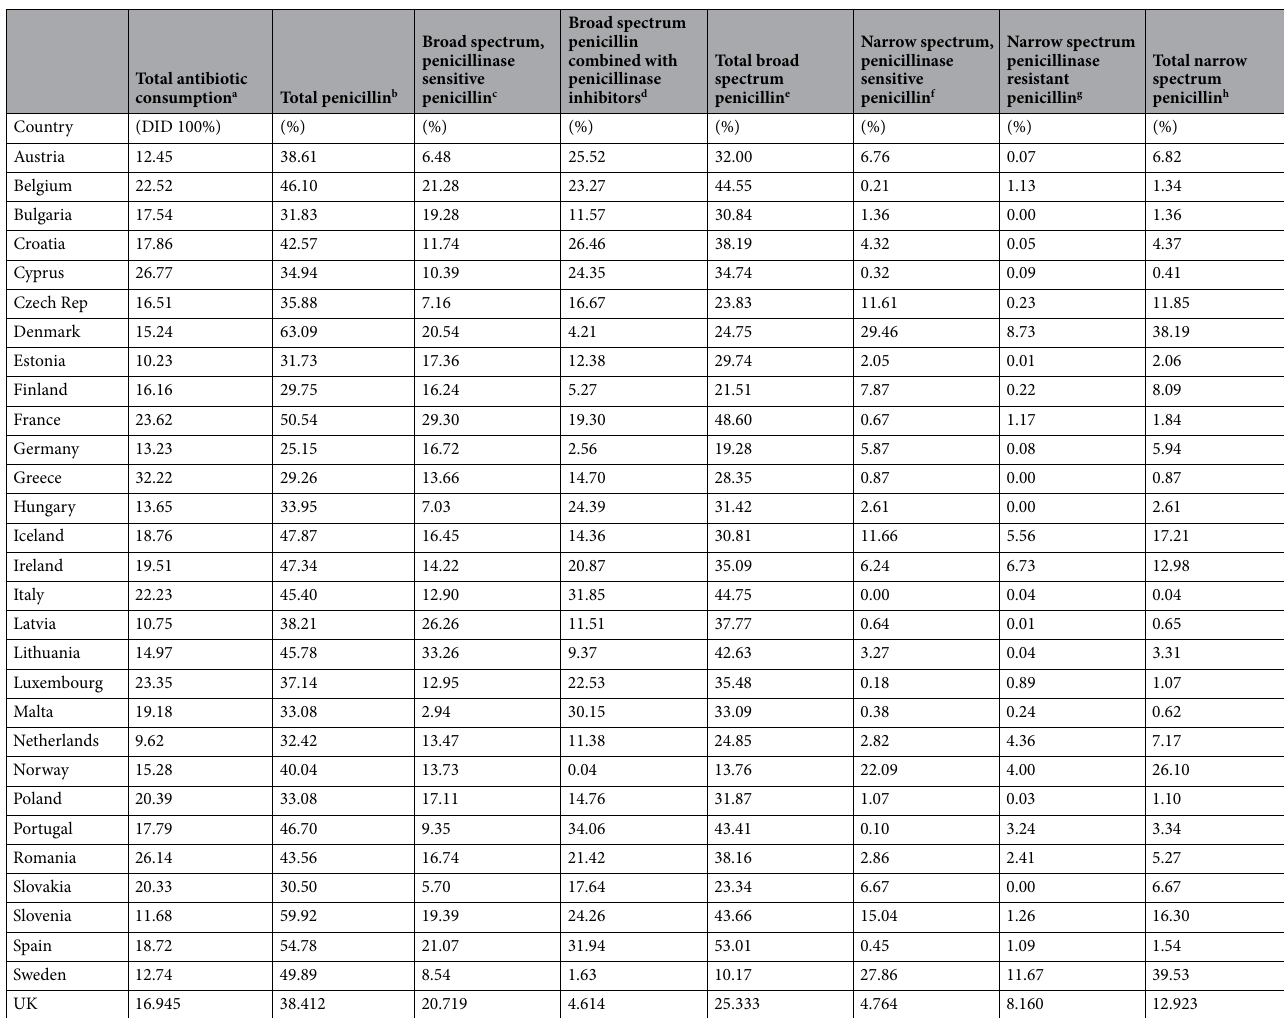
Table 2. Cumulative yearly penicillin consumption (ECDC database 2008–2018). Penicillin consumption (2008–2018), expressed in % of the total consumption (SUM) in DID, according to the ECDC